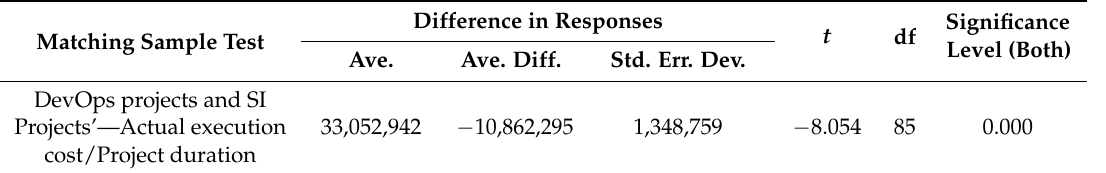
Table 12. Matching sample